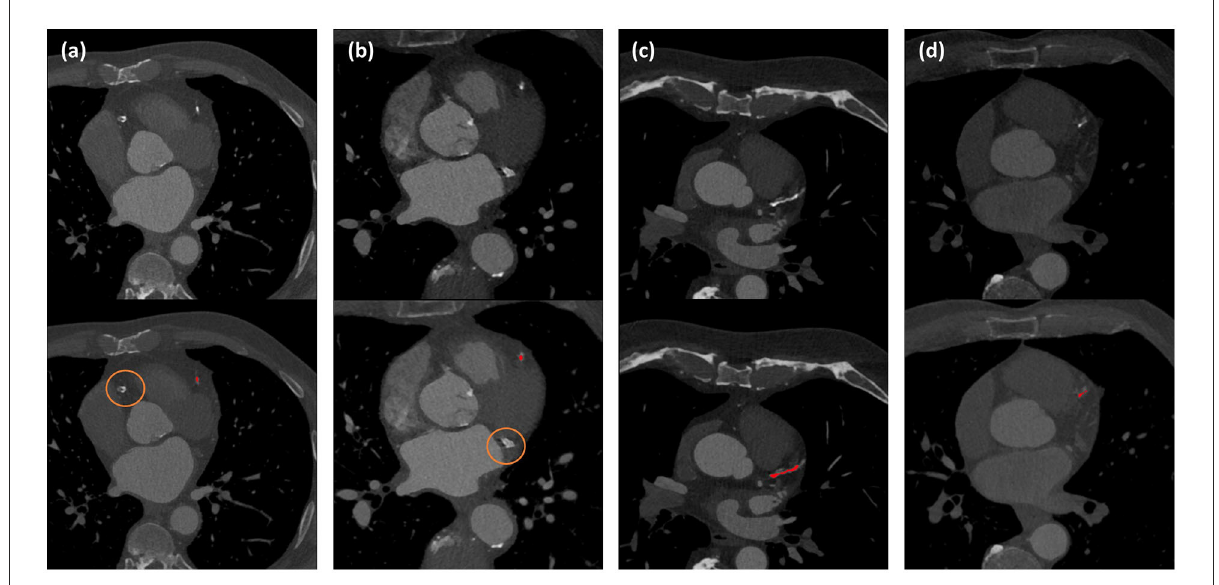
FIGURE4 Automated CAC detection results in CCTA scans of four patients. The images in the first row show CCTA slices and the detected CACs are shown as overlay in the second row. Panels (a) and (b) illustrate the two largest outliers shown by orange dots in Figure 3, and false negative CAC are indicated by orange circles. Panels (c) and (d) show two cases with correct automatic CAC